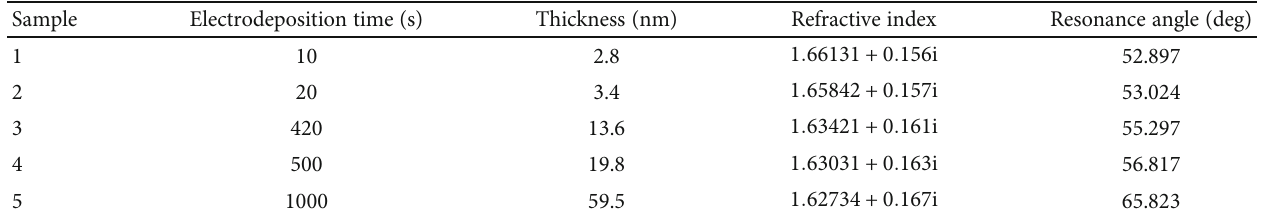
Figure 3: (a) The SPR signals corresponding to di ff erent thicknesses of layer. The resonance angle was in the range of 52.897 ° to 65.823 ° . (b) The SPR signal to determine the baseline (55.297 ° ) for using the detection of MO and MB. Table 1: The resonance angle and the refractive index of